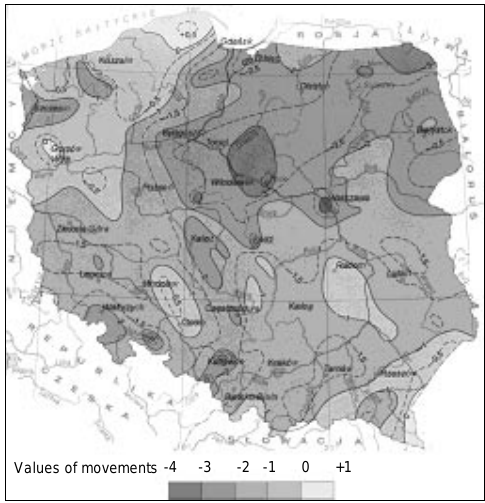
Fig 3. Land uplift in the area of Poland [4]